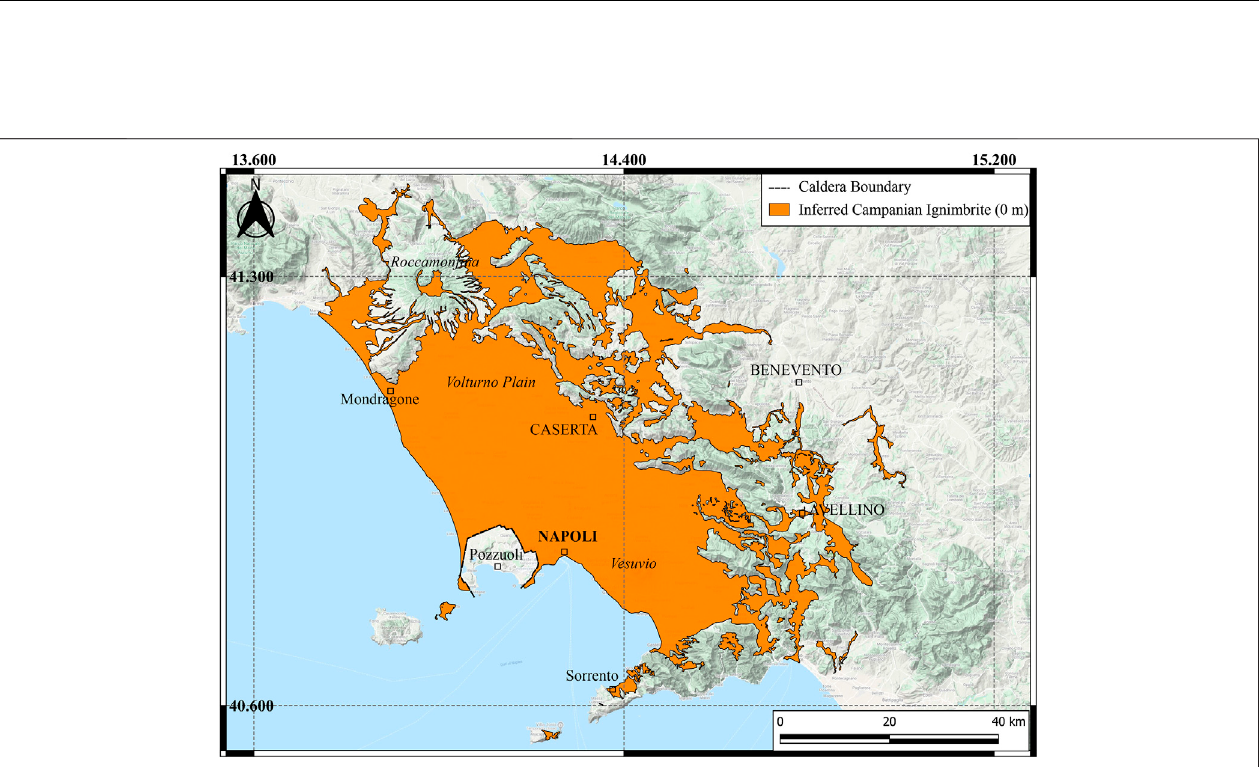
FIGURE 4 | Reconstruction of the areal extent of the ignimbrite deposits, enclosed within the 0 m isopach is shown in orange. The total area covered by the preserved deposits of CI is3,216 km 2 , the envelopment with a shape is equal to 6,095 km 2 ( Online Supplementary Material ).The isolated areas from the source are due to the erosion of veneer facies.